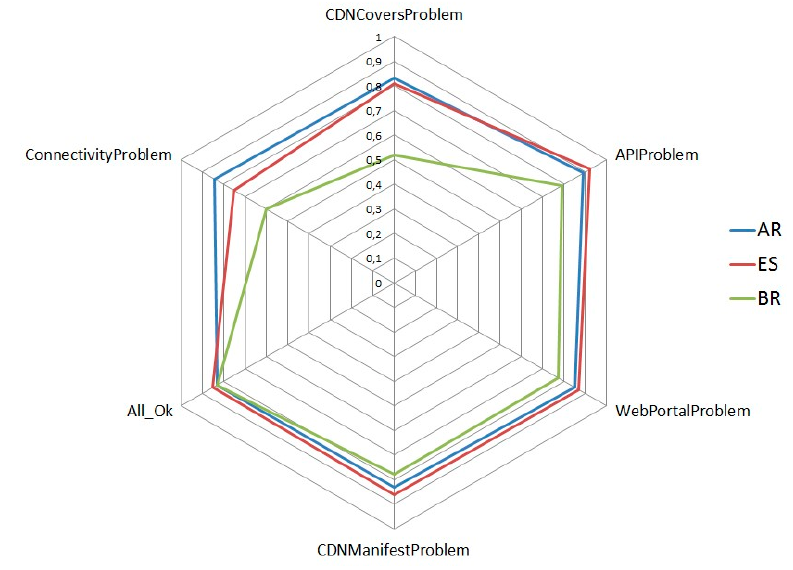
Figure 7. Normalized entropy of various root causes of faults.